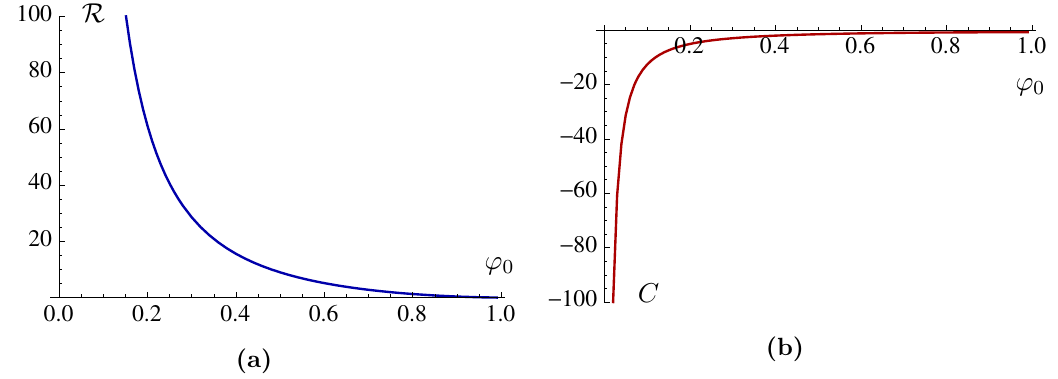
Figure 12. QFT on S d : dimensionless curvature R and dimensionless vev C as a function of IR endpoint ’ 0 for the potential (5.1) with (cid:1) (cid:0) = 1 : 2. Both these quantities diverge as ’ 0 approaches the UV (cid:12)xed point at ’ =